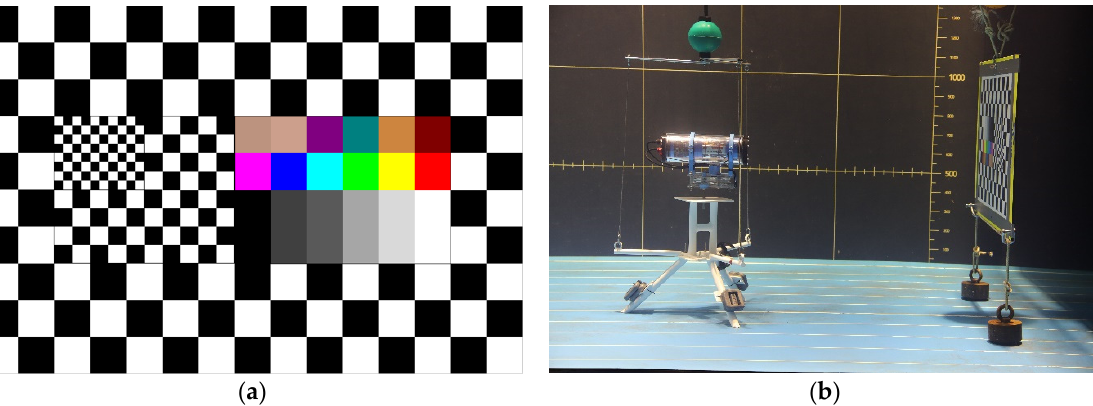
Figure 2. Test pattern use for experimentations ( a ). The KOSMOS system and test pattern in the controlled pool ( b